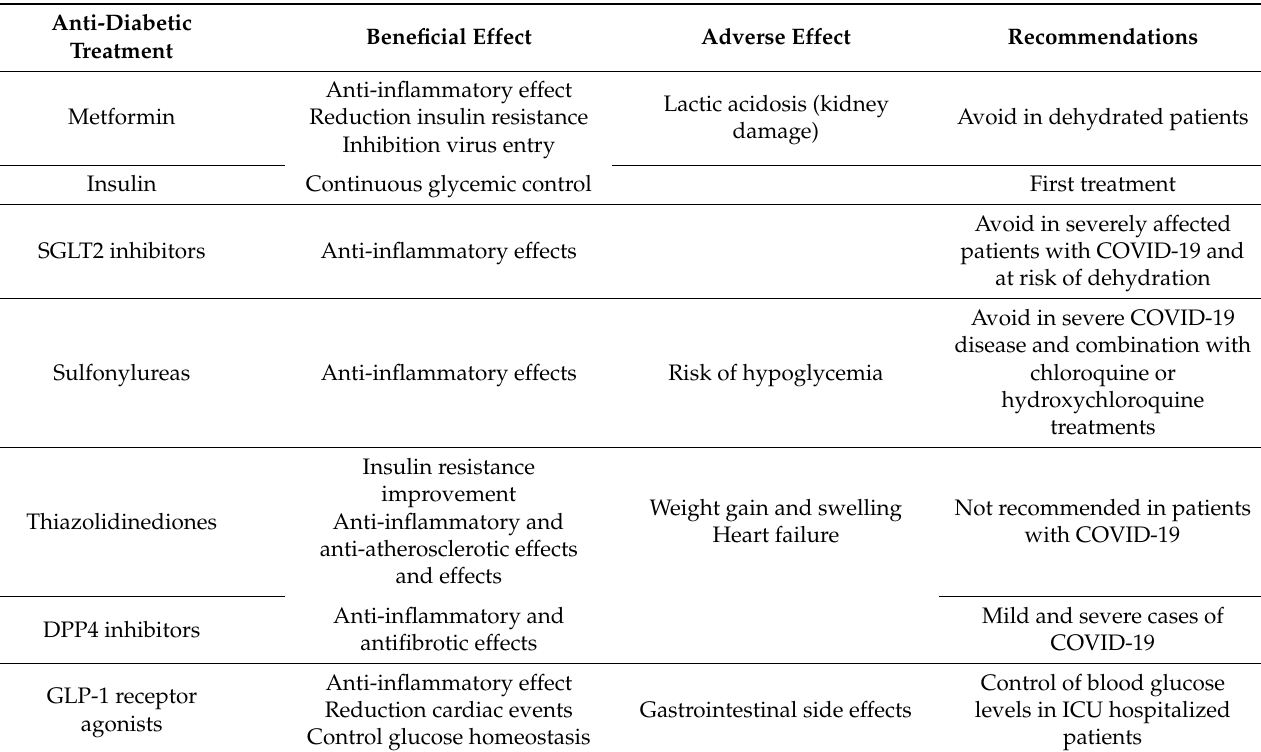
Table 2. Beneficial and adverse effects and clinical recommendations of antidiabetic treatment for